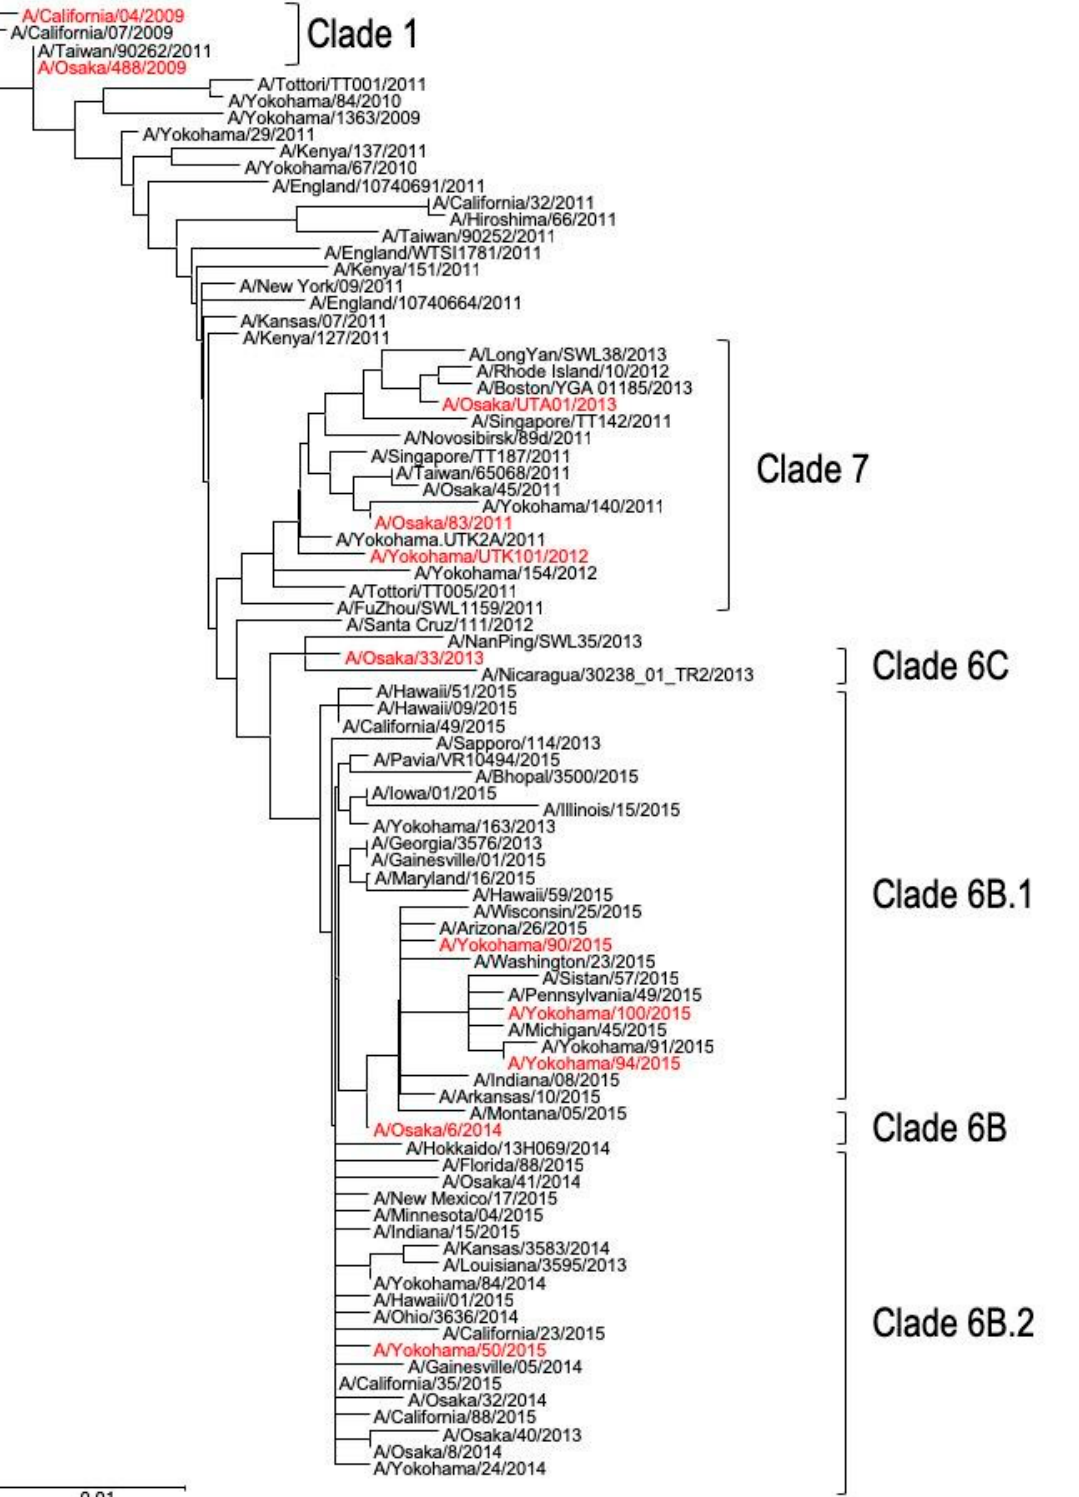
Figure 1. Phylogenetic tree based on hemagglutinin (HA) amino acid sequence. The trees were constructed by using the neighbor-joining method. Viral clades are indicated by brackets [19]. The Japanese isolates used in the present study are indicated in red.